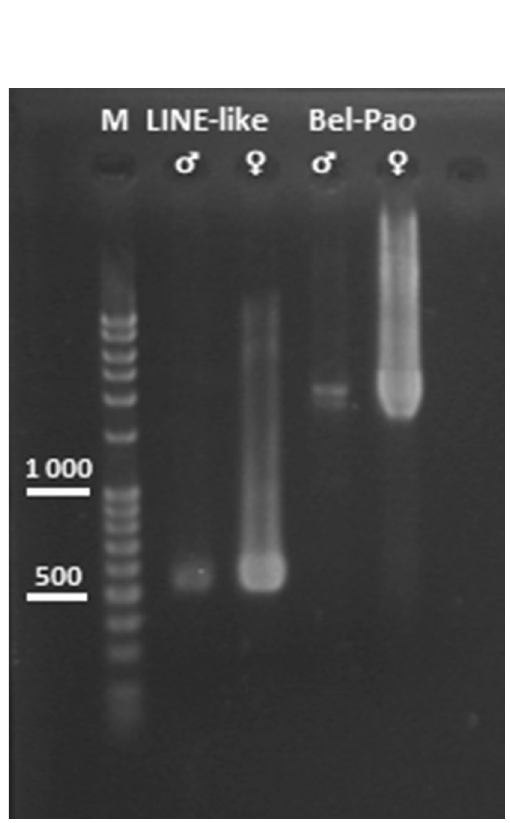
Figure 4. PCR amplification from genomic DNA of both sexes of Peribatodes rhomboidaria . Although the products are present in all samples, they are visibly stronger in females. Legend (from left): M—marker (100 bp DNA ladder, Invitrogen), PRW LINE-like male, PRW LINE-like female (540 bp), PRW Bel-Pao male, PRW Bel- Pao female (2118 bp; note a smaller band of 1905 bp carrying the